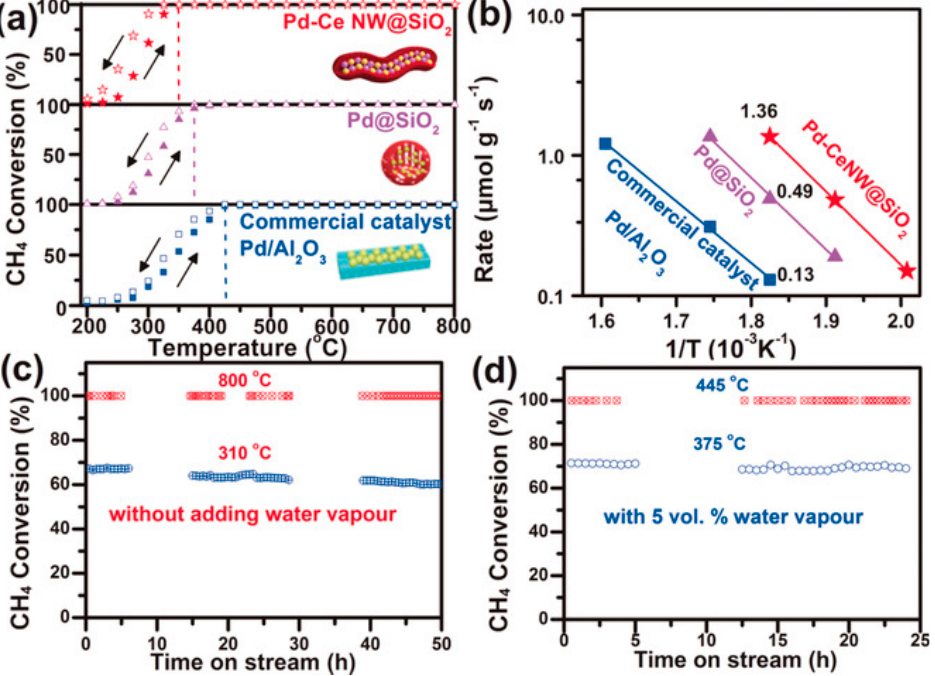
Figure 18. ( a ) Heating and cooling (5 °C/min) light-off curves of CH 4 conversion against temperature for Pd-CeNW@SiO 2 (1.5 wt% Pd), Pd@SiO 2 (1.5 wt% Pd), and a commercial Pd/Al 2 O 3 catalyst (2.0 wt% Pd); ( b ) Arrhenius plots, ( c ) high-temperature stability, and ( d ) water resistance of Pd-